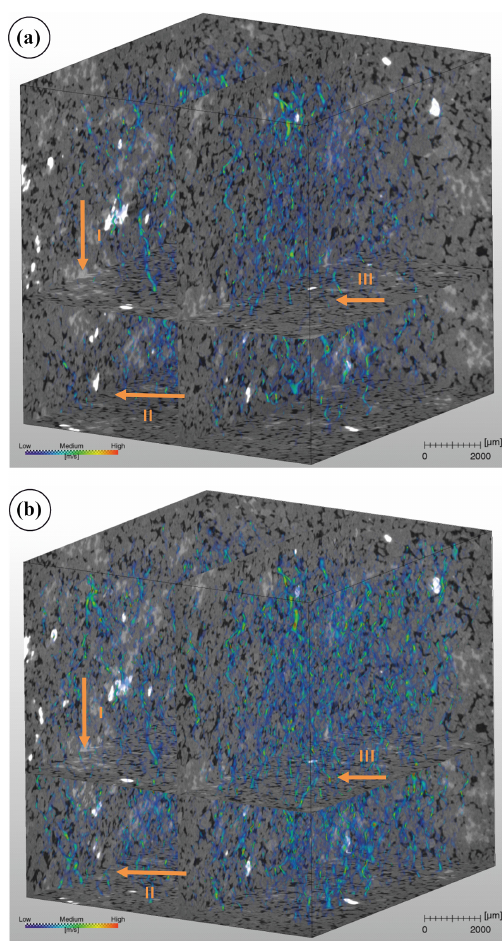
Figure 7. In (a) and (b) the details of the same Permian sandstone sample before (a) and after (b) the seven-week CO 2 experiments under reservoir conditions are shown. Note the reduction of the blocky cements (light grey) and therefore the fluid flow field with increased fluid migration pathways and rather higher migration ve- locities (blue to red colours) after the experiments (b) . This is ver- ified by arrows I to III in a direct comparison of the same sample position before and after the CO 2